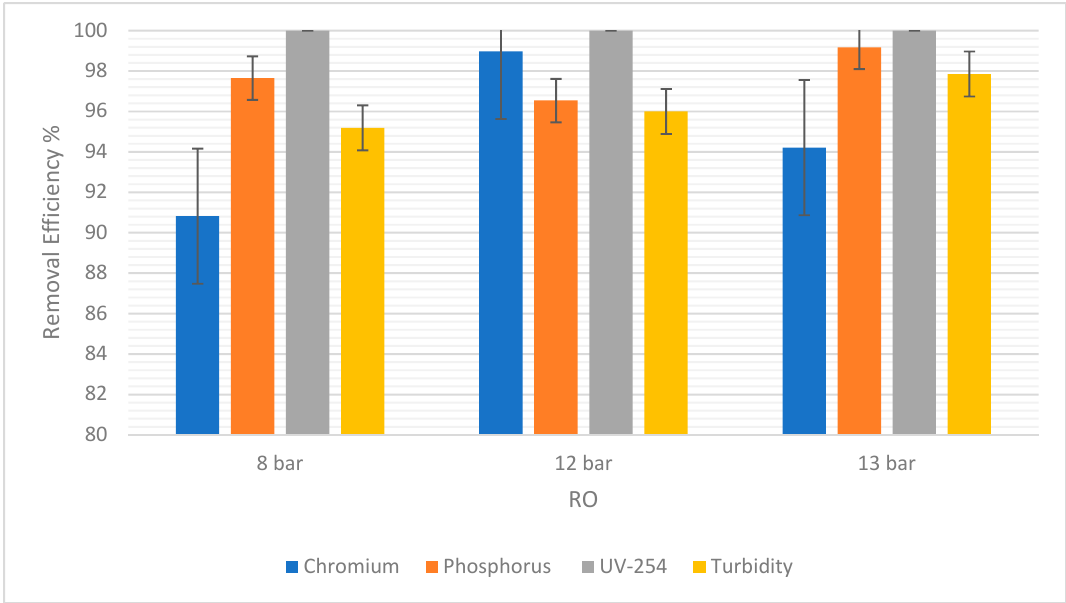
Figure 8. The removal efficiency of pollutants for RO at 8, 12, and 13 bars. Table 5. Average ± SD at different pressures.